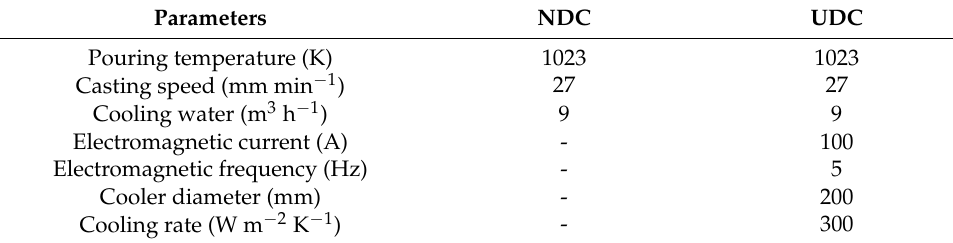
Table 1. Casting process parameters of normal direct chill (NDC) and UDC.